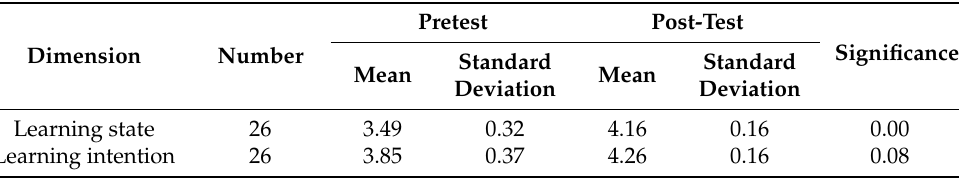
Table 12. Pretest and post-test t -test analyses of Experimental group A programming attitude